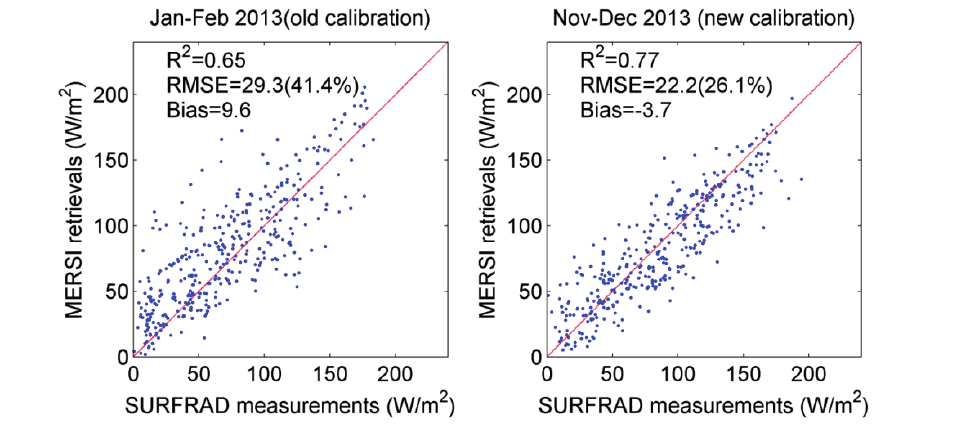
Figure 4. Comparison of validation results of daily SSNR from MERSI before and after the calibration update on 6 March